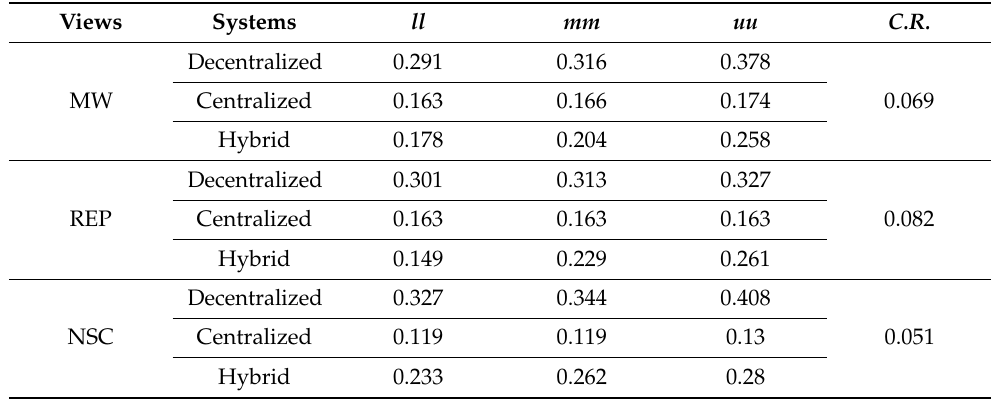
Table 11. The fuzzy weights of cryptocurrency trading systems and C.R